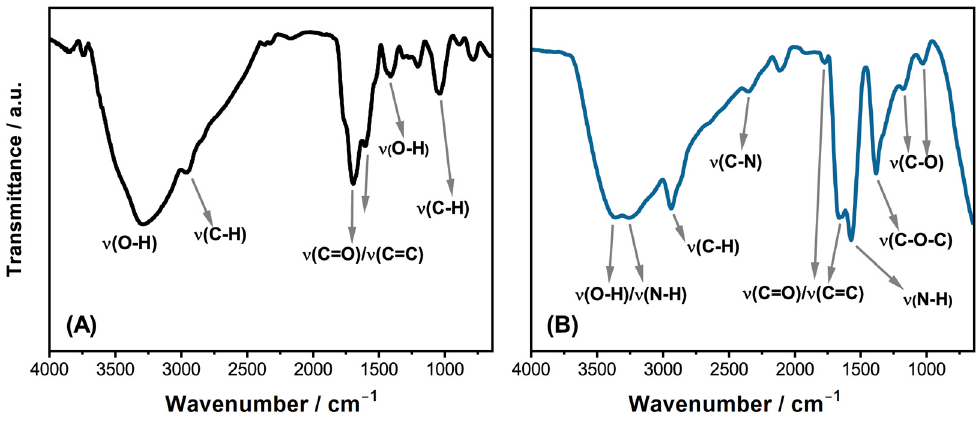
Figure 4. FTIR spectra of ( A ) CQD@Blank and ( B ) CQD@Leu with corresponding vibrational modes.